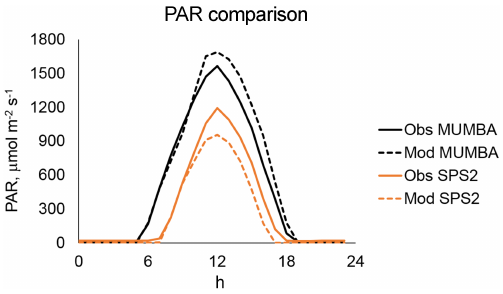
Figure 2. Comparison of photosynthetically active radiation for modelled and measured SPS2 and MUMBA